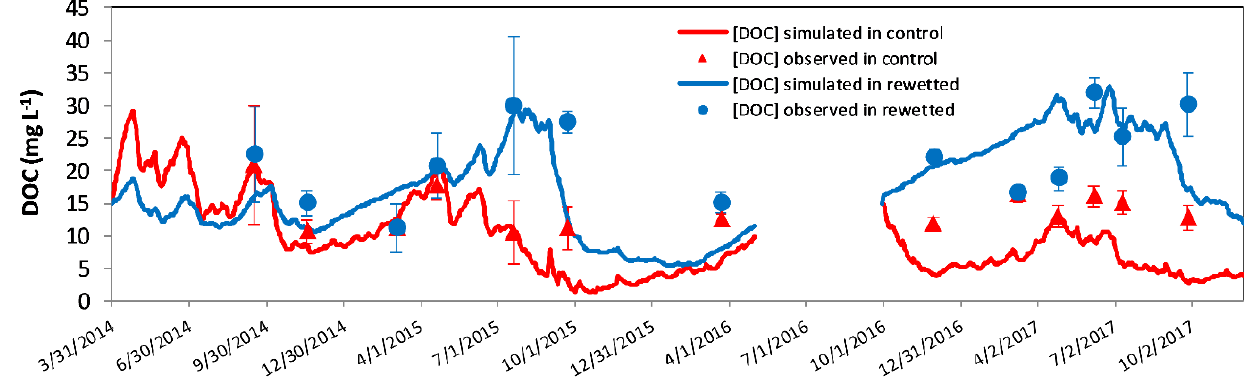
Figure 5. Simulated and observed pore-water DOC in control and rewetted sites. Observations are the average of four samples for each sampling date. Error bars indicate standard